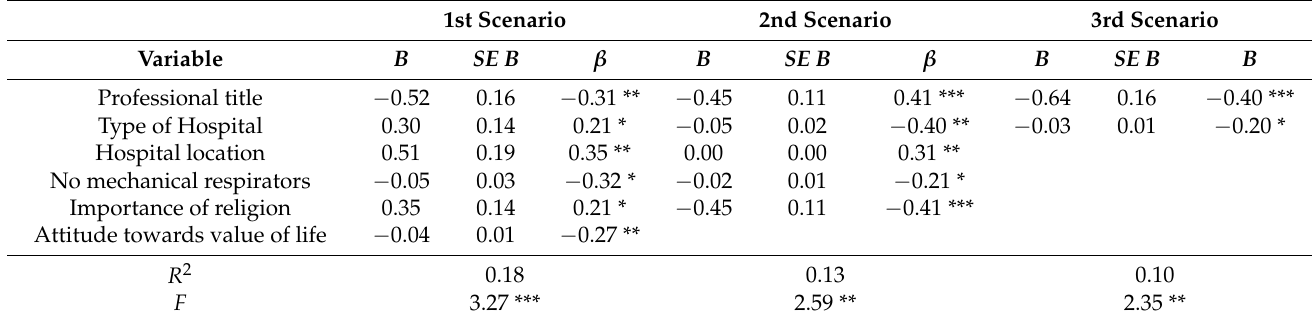
Table 4. Summary of multiple regression analysis for variables predicting healthcare professionals’ therapeutic inten- siveness (healthcare professionals declared intended behavior) expressed as the summary score from answers to three clinical